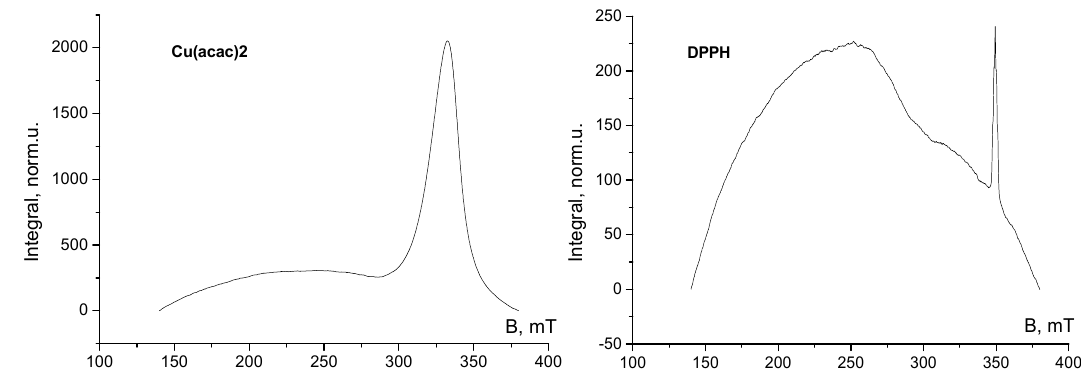
Figure 2. First integrals of the spectra from Figure 1. Note the order-of-magnitude y -axis scale increase for the Cu 2+ standard.